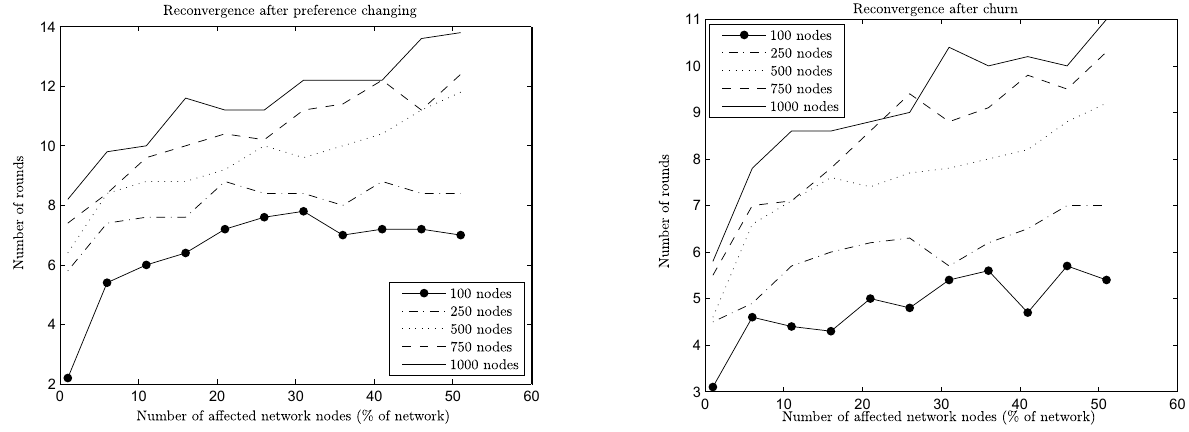
Figure 6. Reconvergence speed for preference change and churn